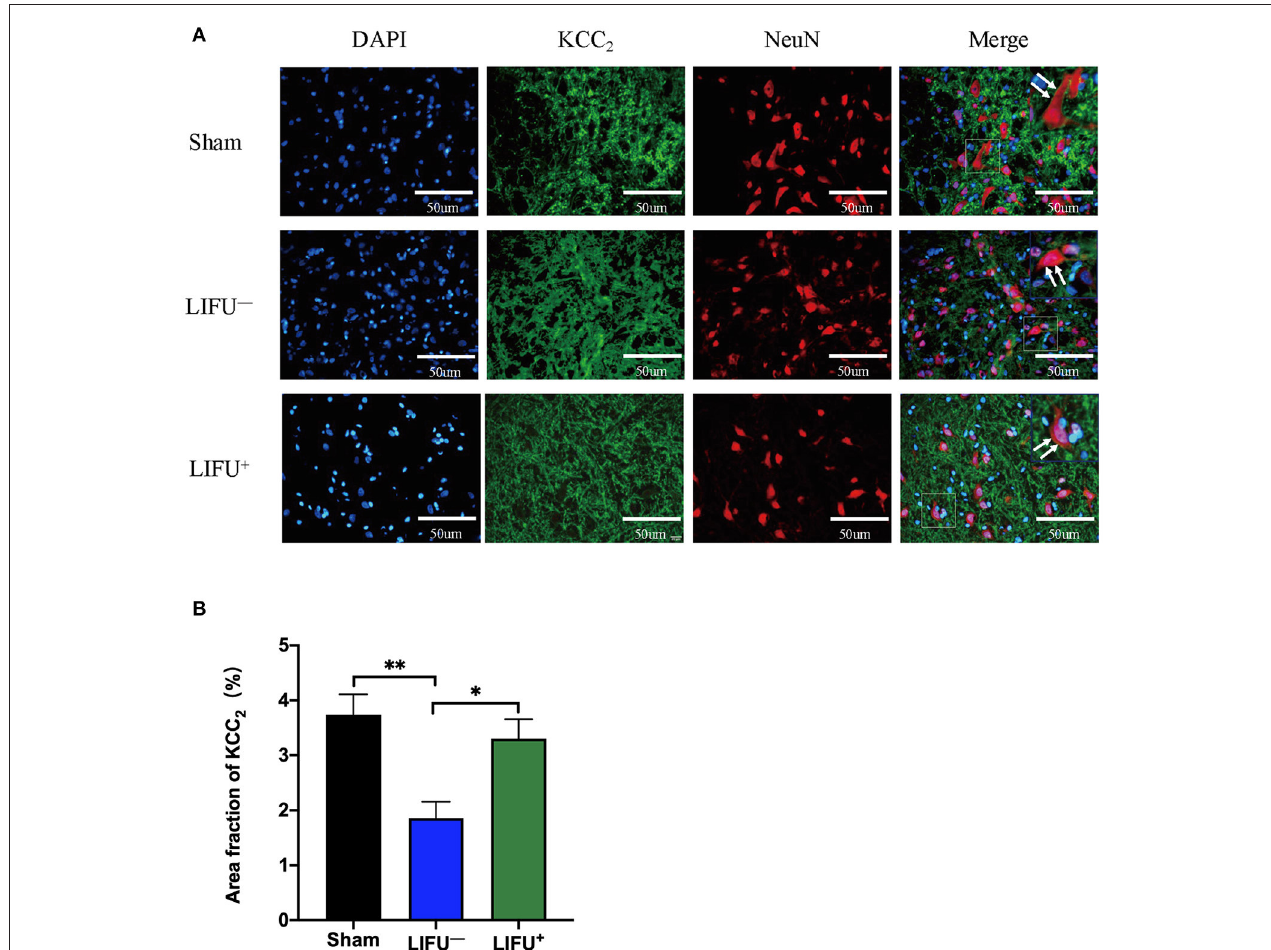
FIGURE 6 | Immunofluorescence (IF) staining showing the expression of KCC. (A) Positive expressions of KCC 2 are stained green and neurons are stained red; the expression of KCC 2 was merged on the membranes of neurons (white arrow). (B) Histogram showing expression of the KCC 2 protein for the different groups. The results show that the intensity of KCC 2 expression was significantly reduced (** P < 0.01, compared with the sham group; one-way ANOVA with LSD test; n = 5, mean ± SEM); following LIFU treatment, the intensity of KCC 2 expression significantly increased (* P < 0.05, compared with the LIFU − group; one-way ANOVA with LSD test; n = 5, mean ± SEM). Scale bar = 50 µ